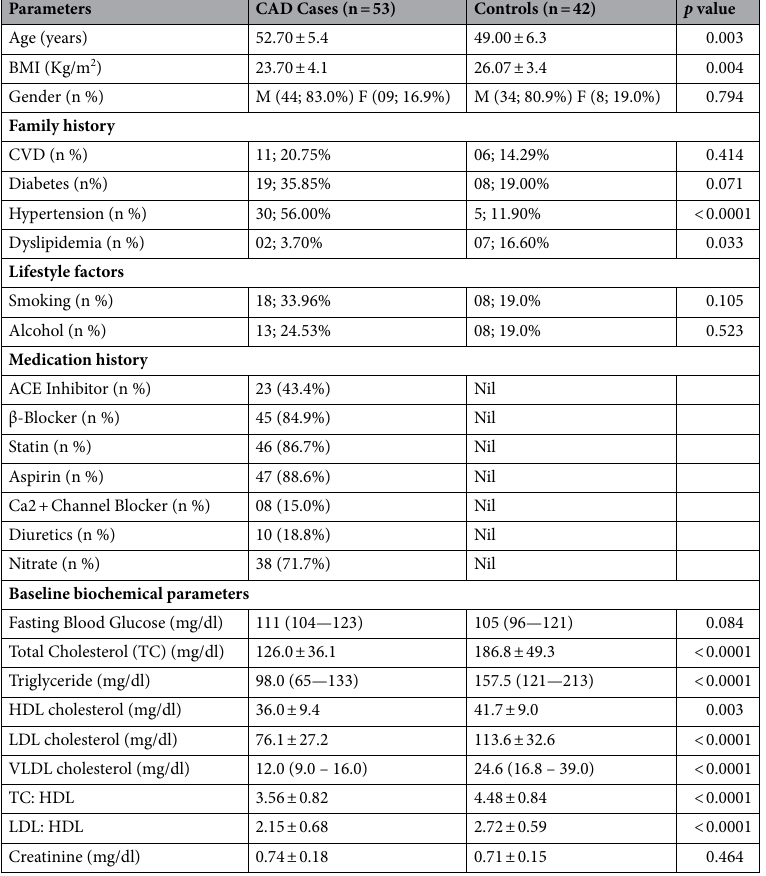
Table 1. Demographic, anthropometric, medication history and biochemical variables in CAD cases and healthy controls. Data expressed as mean ± standard deviation for normally distributed data and as median and interquartile range (IQR) for non-normally distributed data. Categorical variables were represented in percentage. Unpaired t-test and Mann Whitney test U was performed for normally and non-normally distributed data and Chi2 test for categorical variables respectively. p values ≤ 0.05 was considered statistically